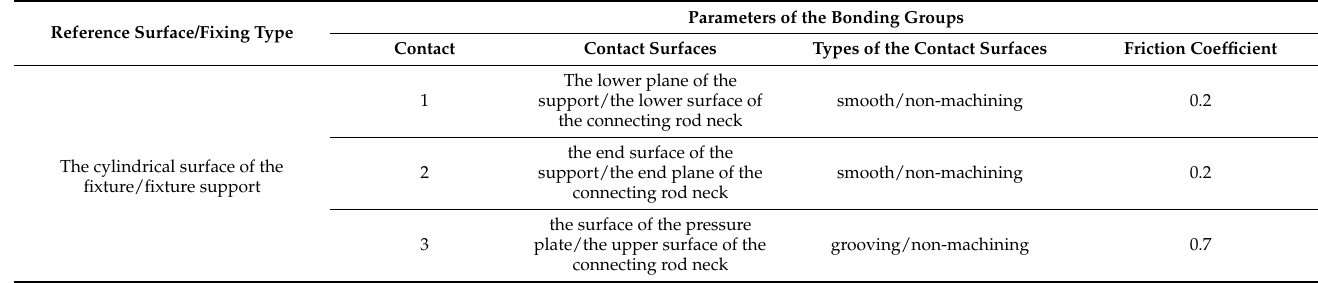
Table 1. Boundary conditions for numerical simulation of the system “fixture–workpiece”.